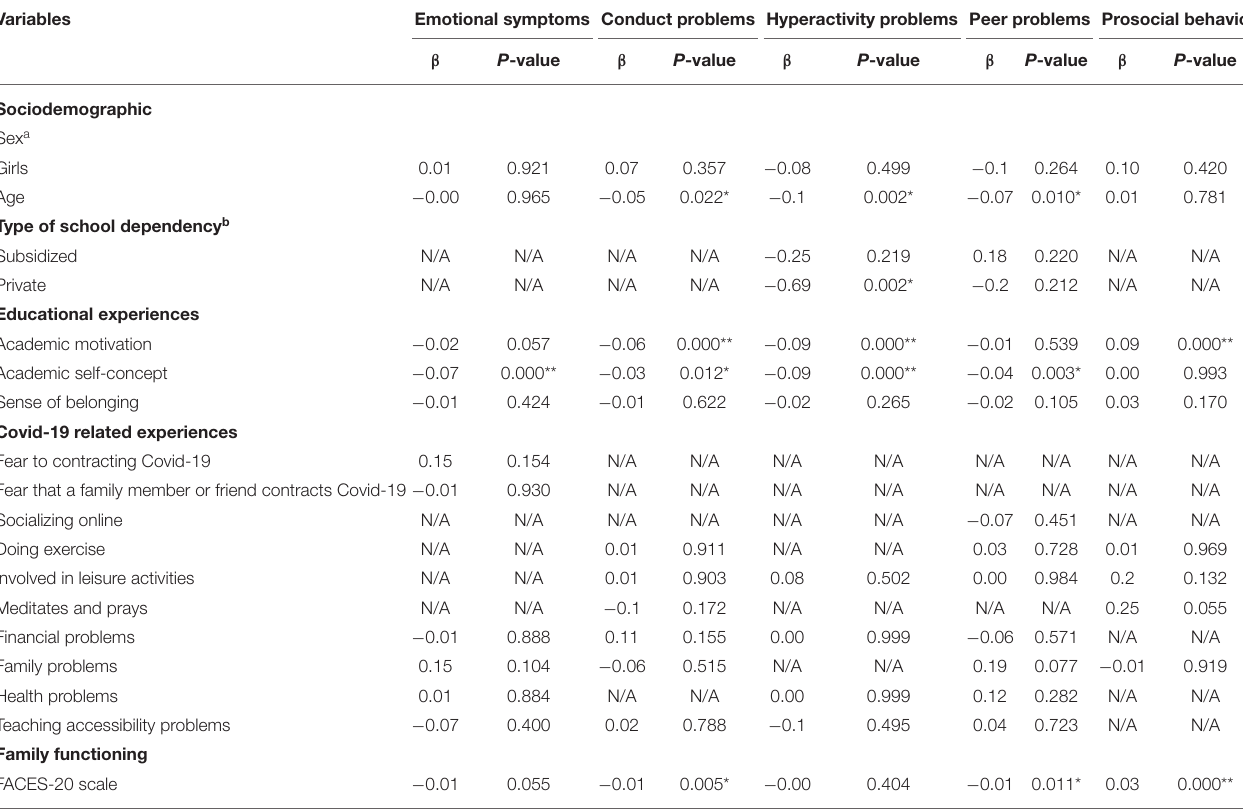
TABLE 2 | Adjusted regression models exploring the association between risk and protective factors and mental health problems among children.